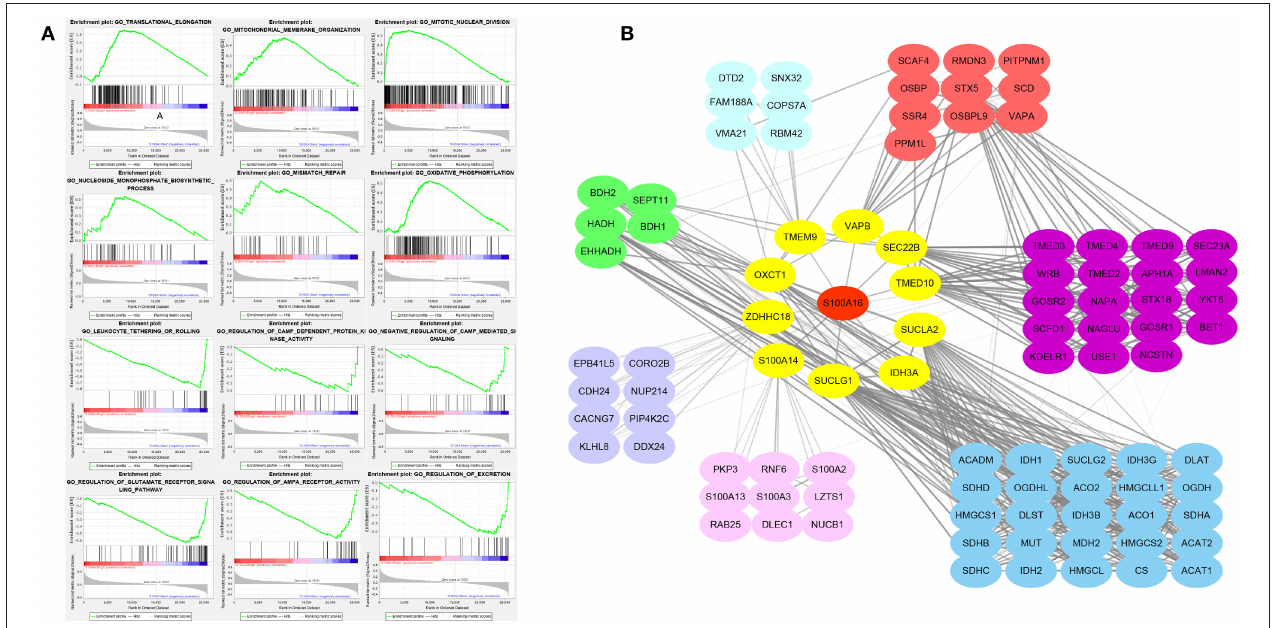
FIGURE 12 | Enrichment plots from GSEA analysis. GSEA analysis showed that translational elongation, mitochondrial membrane organization, mitotic nuclear division, nucleoside monophosphate biosynthetic process, and mismatch repair oxidative phosphorylation was differentially enriched in the S100A16 high expression phenotype. Leukocyte tethering or rolling, regulation of CAMP-dependent protein kinase activity, negative regulation of CAMP-mediated signal, regulation of glutamate receptor signaling pathway, regulation of AMPA receptor activity, and regulation of excretion was differentially enriched in the low expression phenotype of S100A16. Translational elongation, mitochondrial membrane organization, mitotic nuclear division, nucleoside monophosphate biosynthetic process, and mismatch repair oxidative phosphorylation was differentially enriched in the low expression phenotype of S100A16. (A) Protein-protein interaction network for S100A16 in PDAC (B)